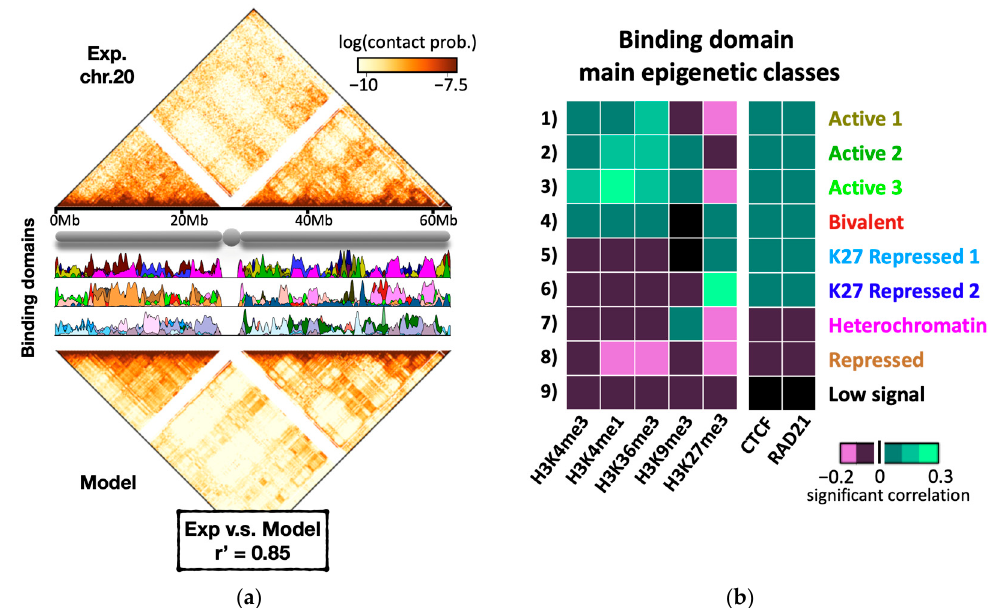
Figure 5. A combinatorial epigenetic code links 1D and 3D chromatin structures. ( a ) Top: in situ Hi-C data [25] of chromosome 20 at 5 kb of resolution in the human GM12878 cell line. Middle: position and abundance of the different binding domains along chromosome 20. The colors reflect the specific association of each domain with a set of key epigenetic marks (see panel b ). Bottom: the contact matrix inferred from the model shows a contact pattern similar to Hi-C (r’ = 0.85). Similar results are found across chromosomes [95]. ( b ) According to their correlation with key histone marks, the genome-wide binding domains of the model cluster in nine epigenetic classes matching well the chromatin states found in epigenetic segmentation studies [95]. The heatmap shows the histone profile of the centroid of each class. Interestingly, some but not all the classes also correlate with CTCF and cohesin, suggesting that a specific combination of genome organizing factors, including but not limited to CTCF and cohesin, links 3D chromatin architecture to 1D chromatin states. Adapted from [95].